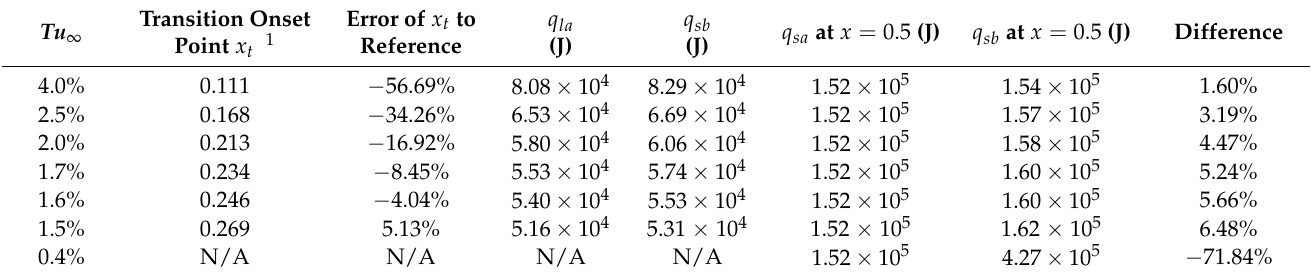
Table 6. Comparison of the results of SA-BCM model with experiment data.